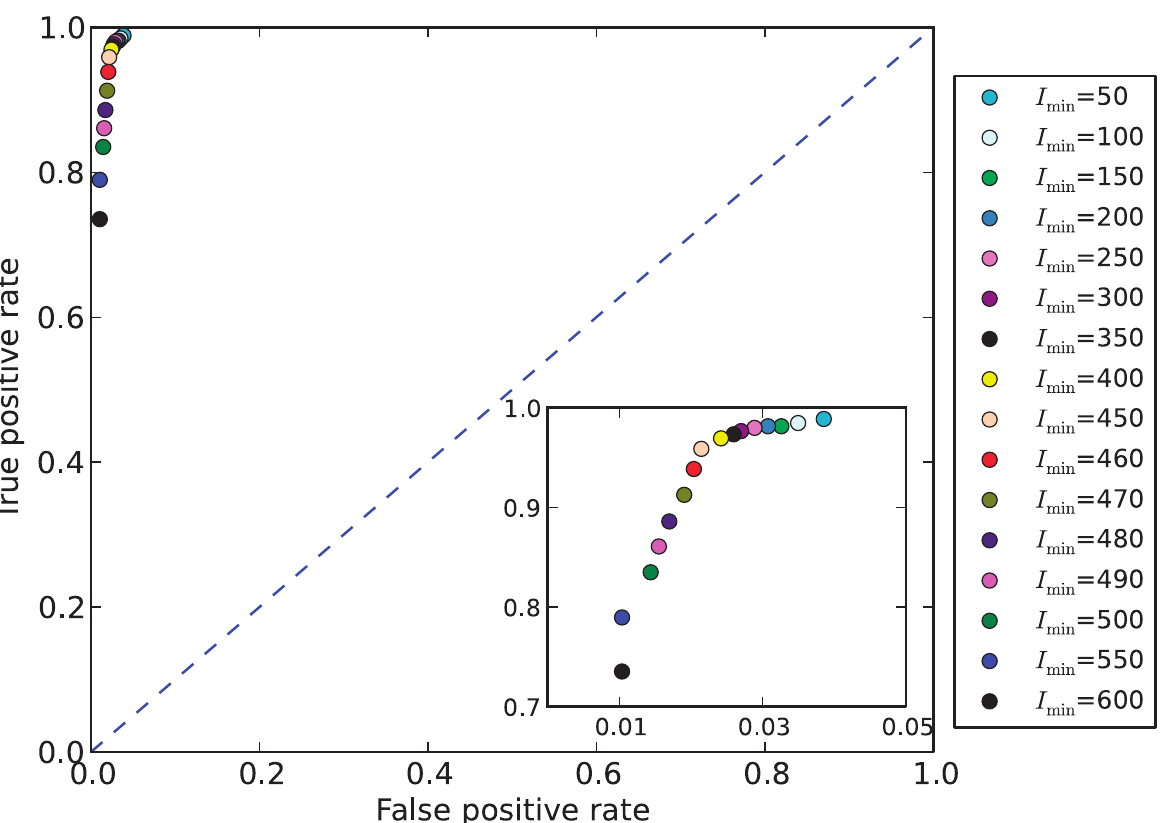
Fig 4. Receiver Operating Characteristic (ROC) graph. The graph shows the true positive rate versus the false positive rate. I min = 450 μ mol photons m -2 s -1 (pink dot) is the nearest to the (0, 1) point in the graph and therefore represents the best model result. The small inset is a zoom of the graph area where all the data points occur. The dashed blue line represents points in which true positive rates equal false positive